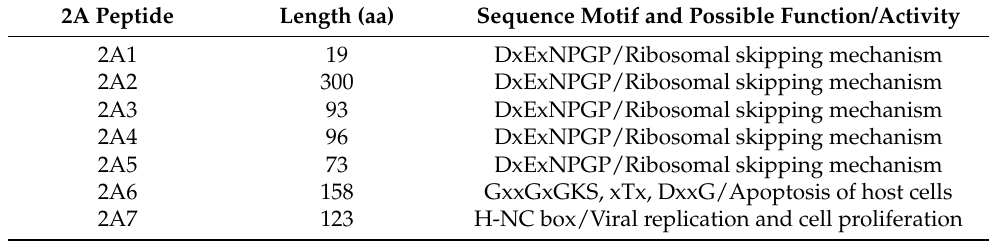
Table 2. The seven 2A peptide of DERSV.